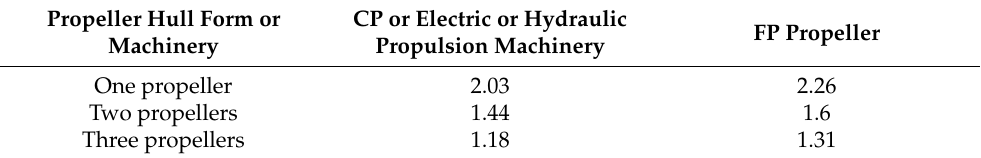
Table 1. Calculation parameter value ( K e